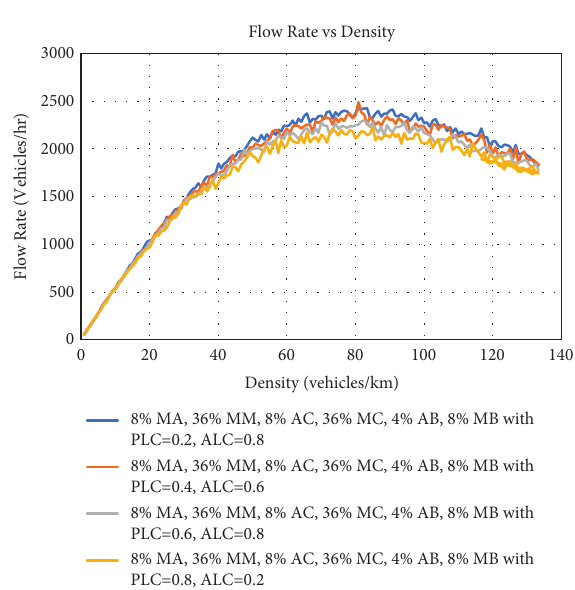
Figure 14: Flow rate vs. density fundamental diagrams for different compositions of MA, MM, AC, MC, AB, and MB with different values of ALC and PLC.